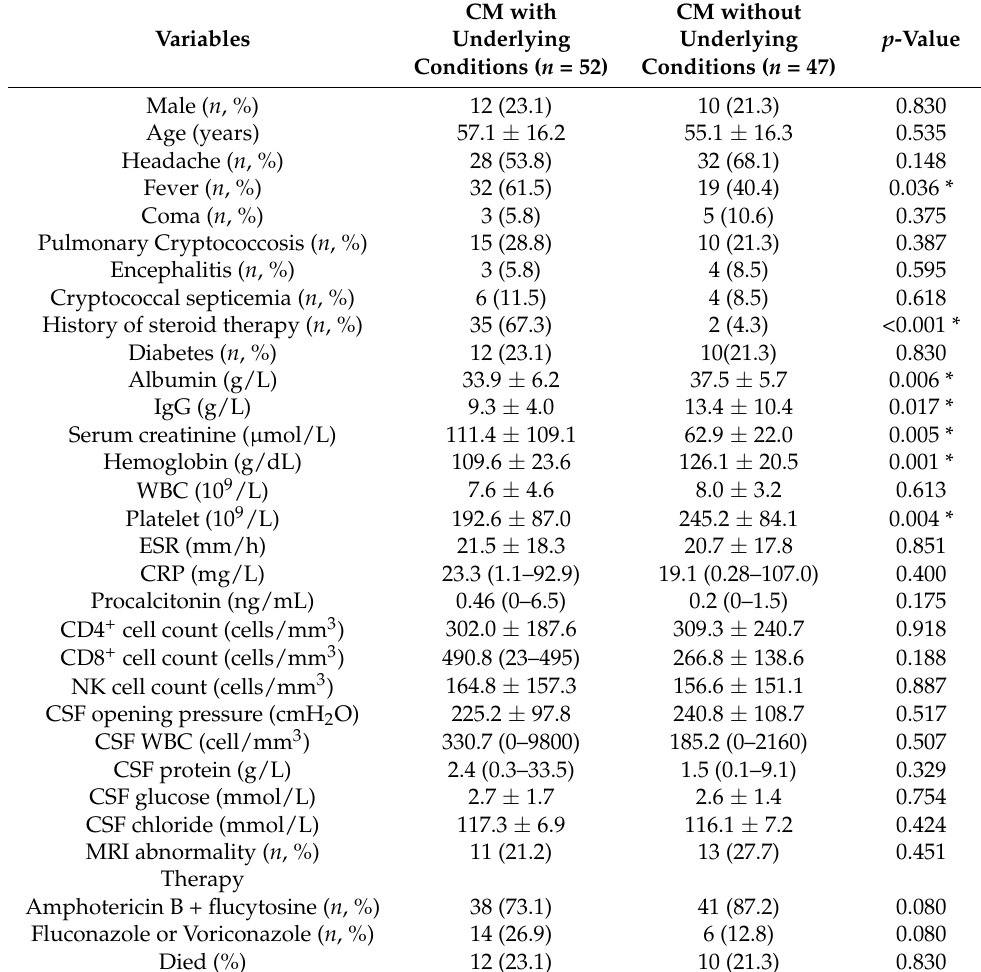
Table 1. Clinical characteristics of cryptococcal meningitis (CM) patients with and without underlying conditions ( n =